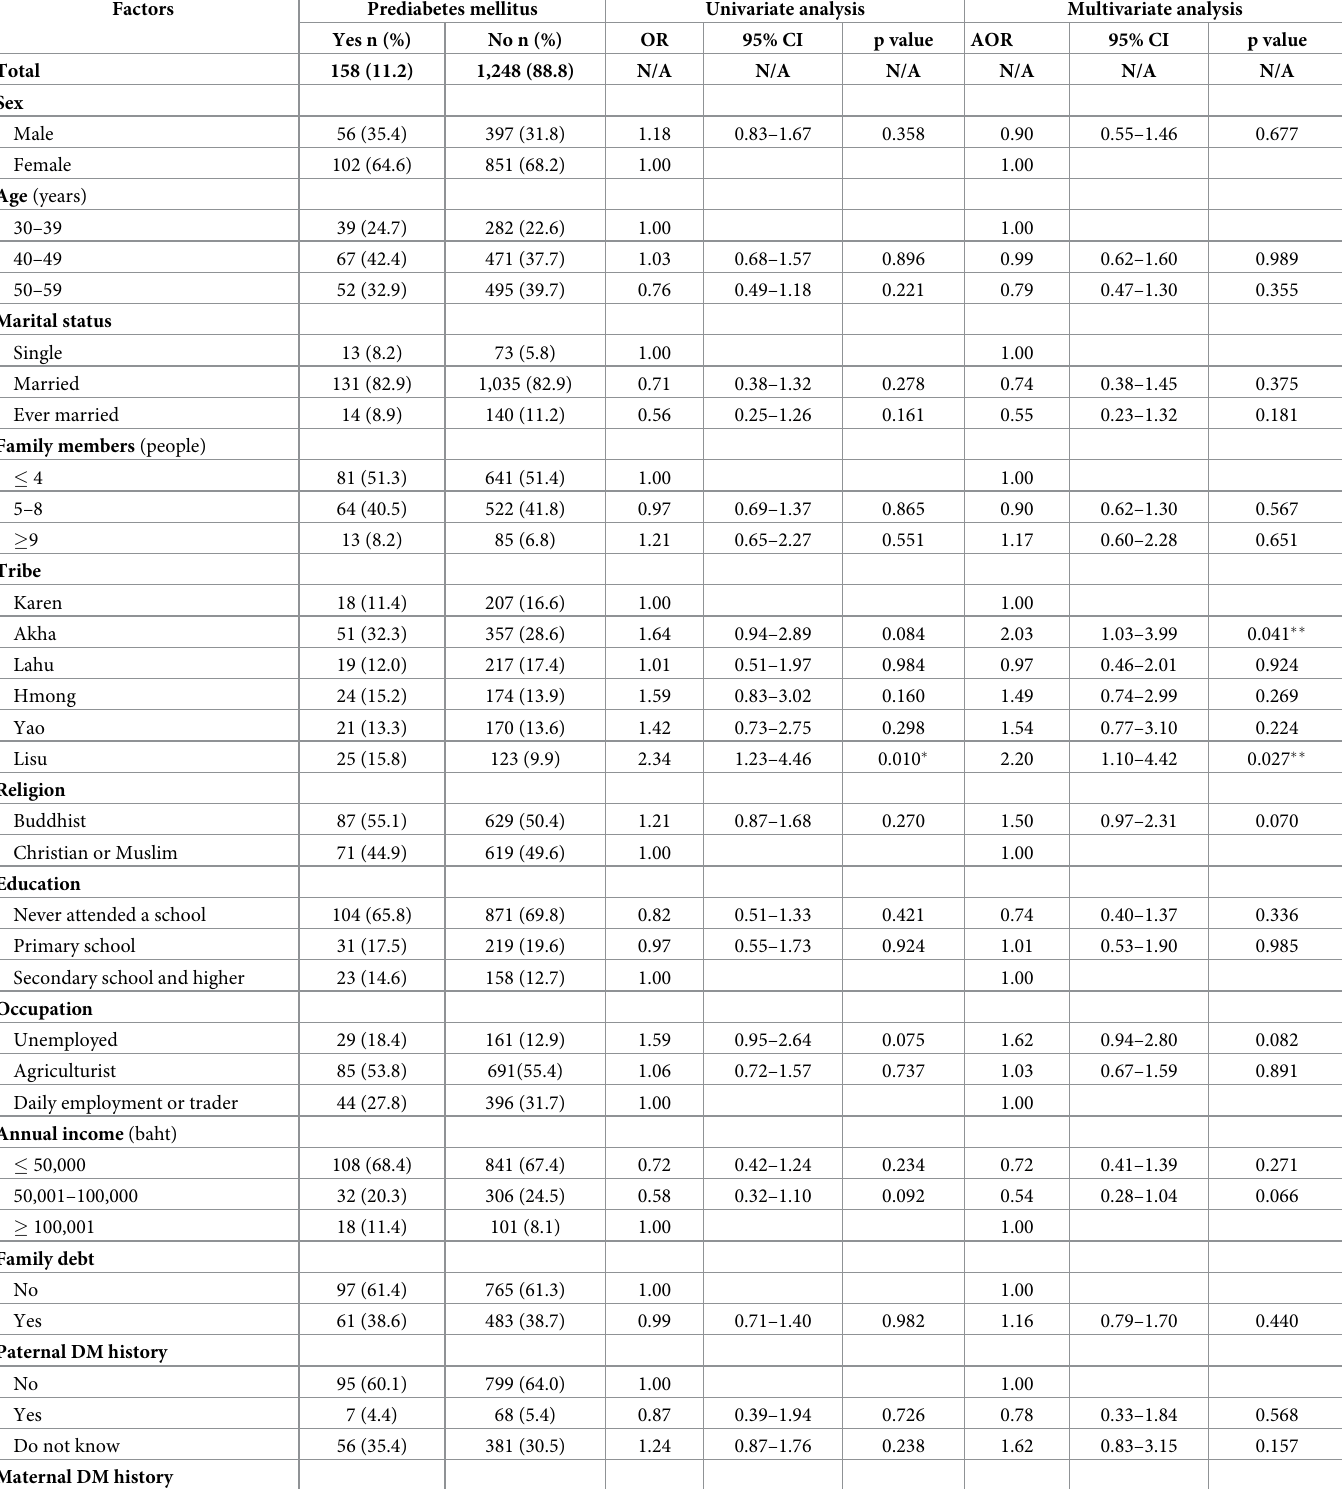
Table 2. Factors associated with prediabetes mellitus in the univariate and multivariate logistic regression analyses. Factors Prediabetes